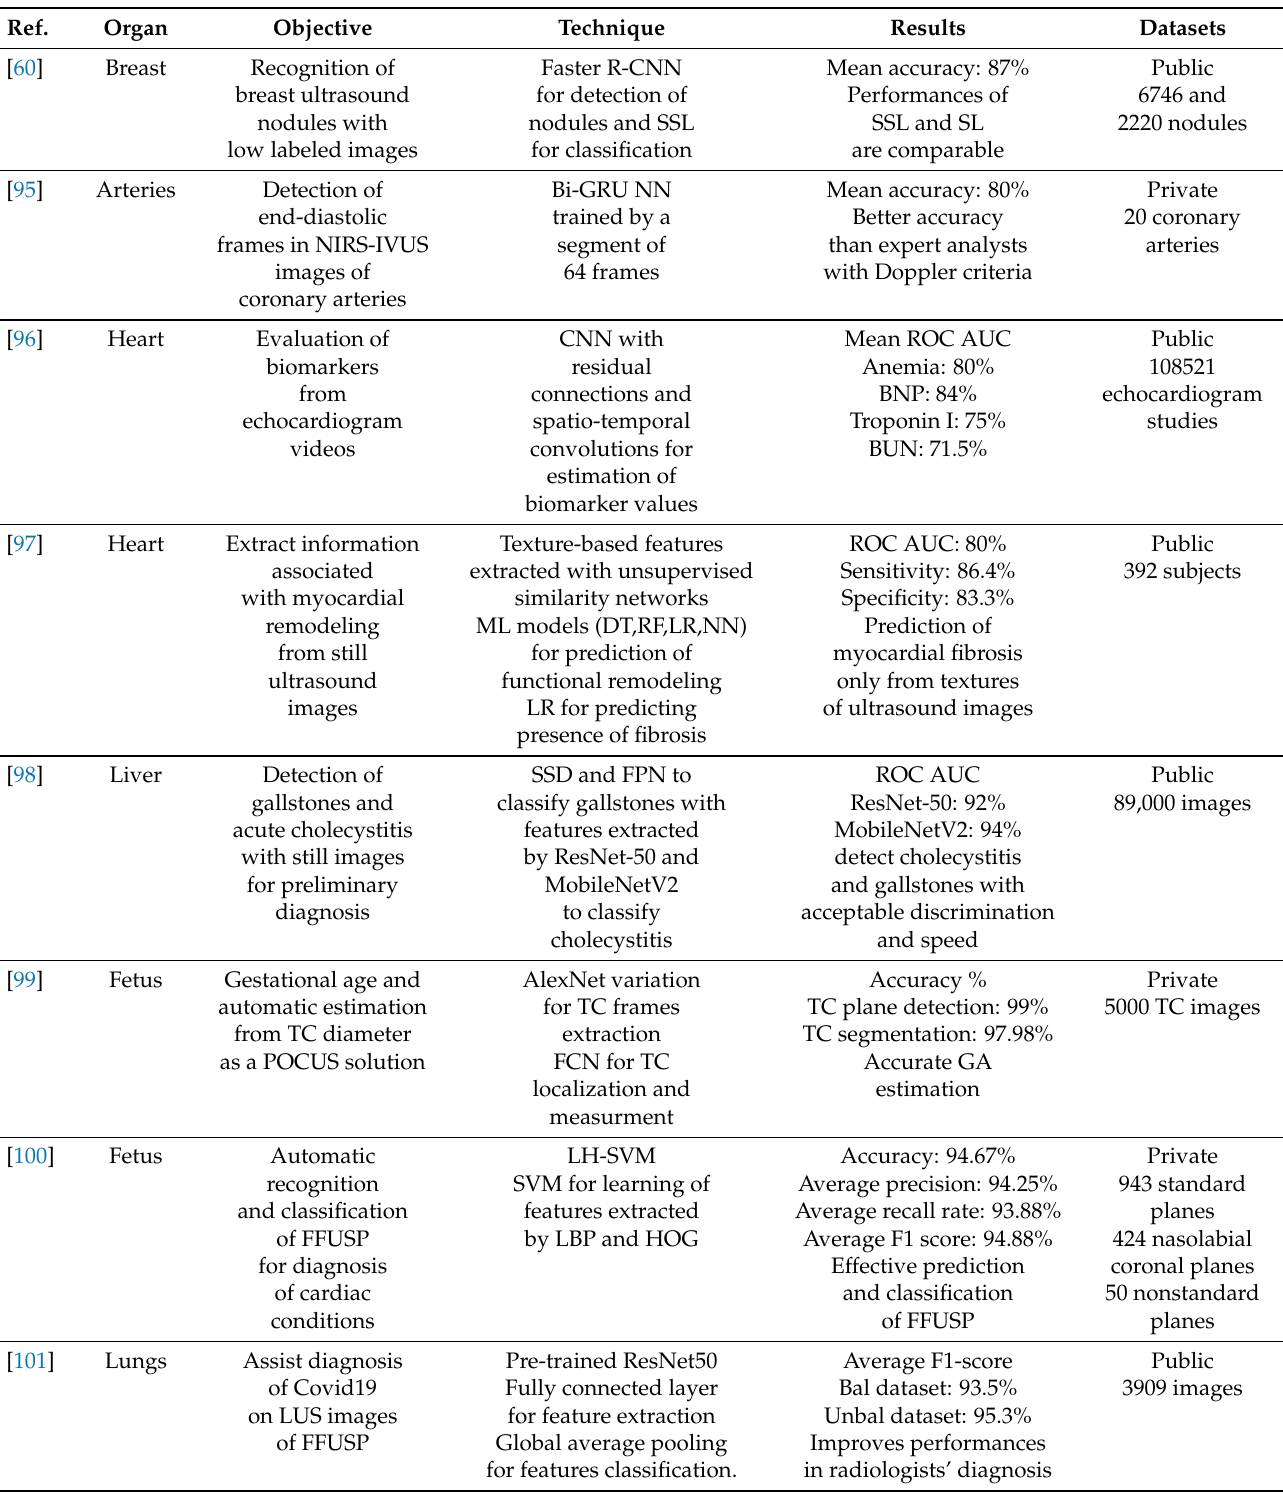
Table 1. Summary of Detection ML algorithms employed in analyzed studies with respect to organ investigated, diagnosis objective, dataset used, and main results achieved.